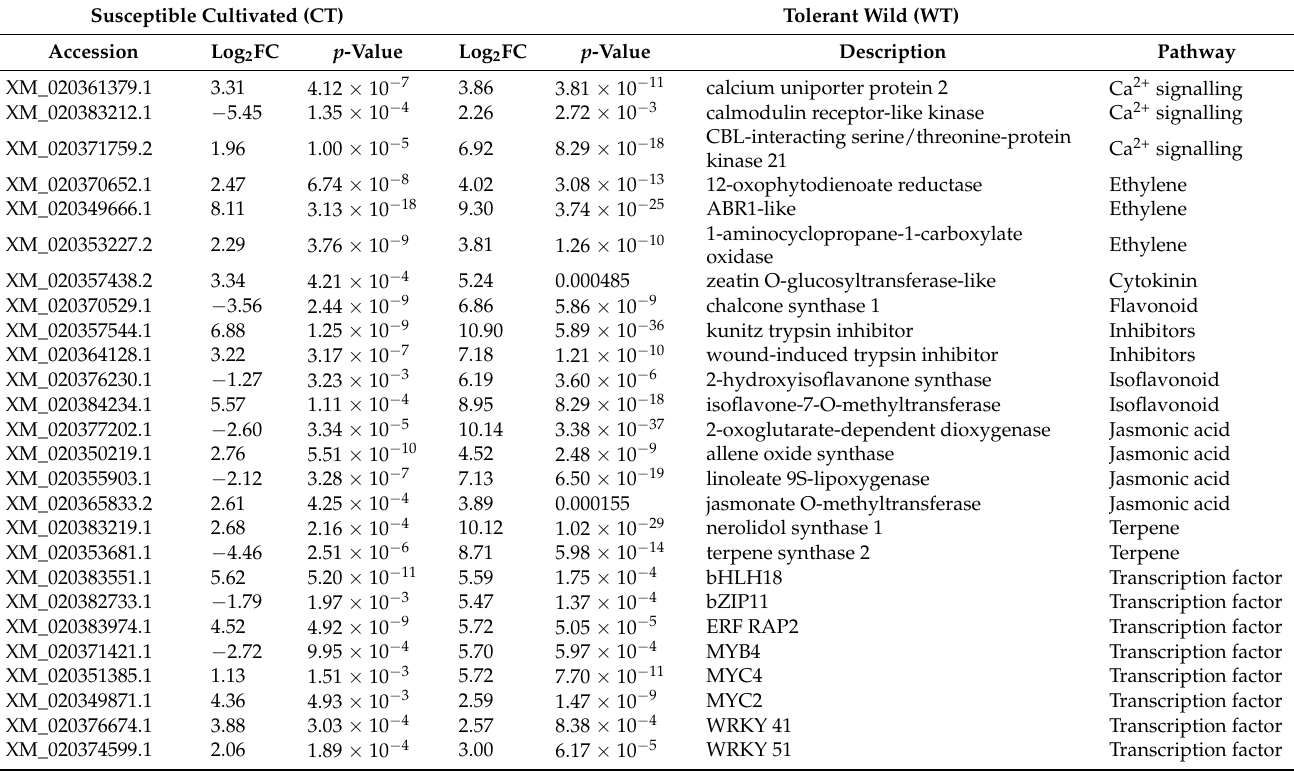
Table 1. Comparison of selected herbivory-induced genes and pathways shared between susceptible cultivated genotype (CT) and resistant wild accession